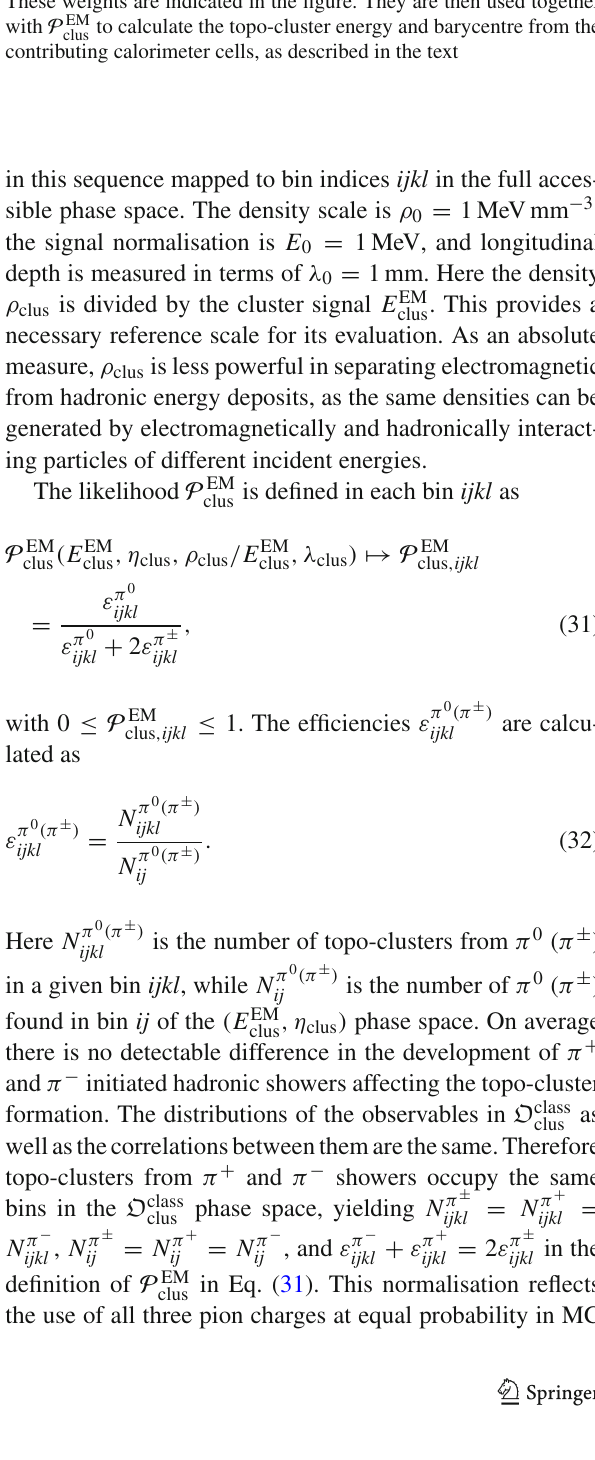
signal weights for the two possible interpretations of the cluster signals. These weights are indicated in the figure. They are then used together with P EM to calculate the topo-cluster energy and barycentre from the clus contributing calorimeter cells, as described in the